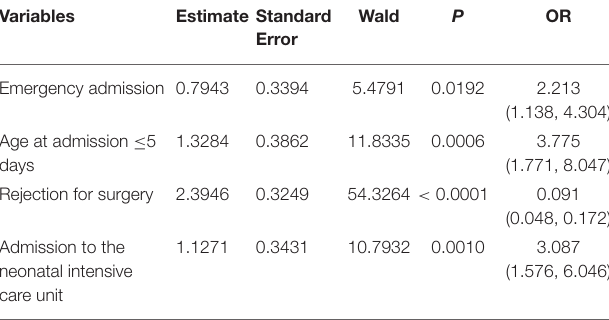
TABLE 3 | Multivariate logistic regression analysis of prediction of DAMA.